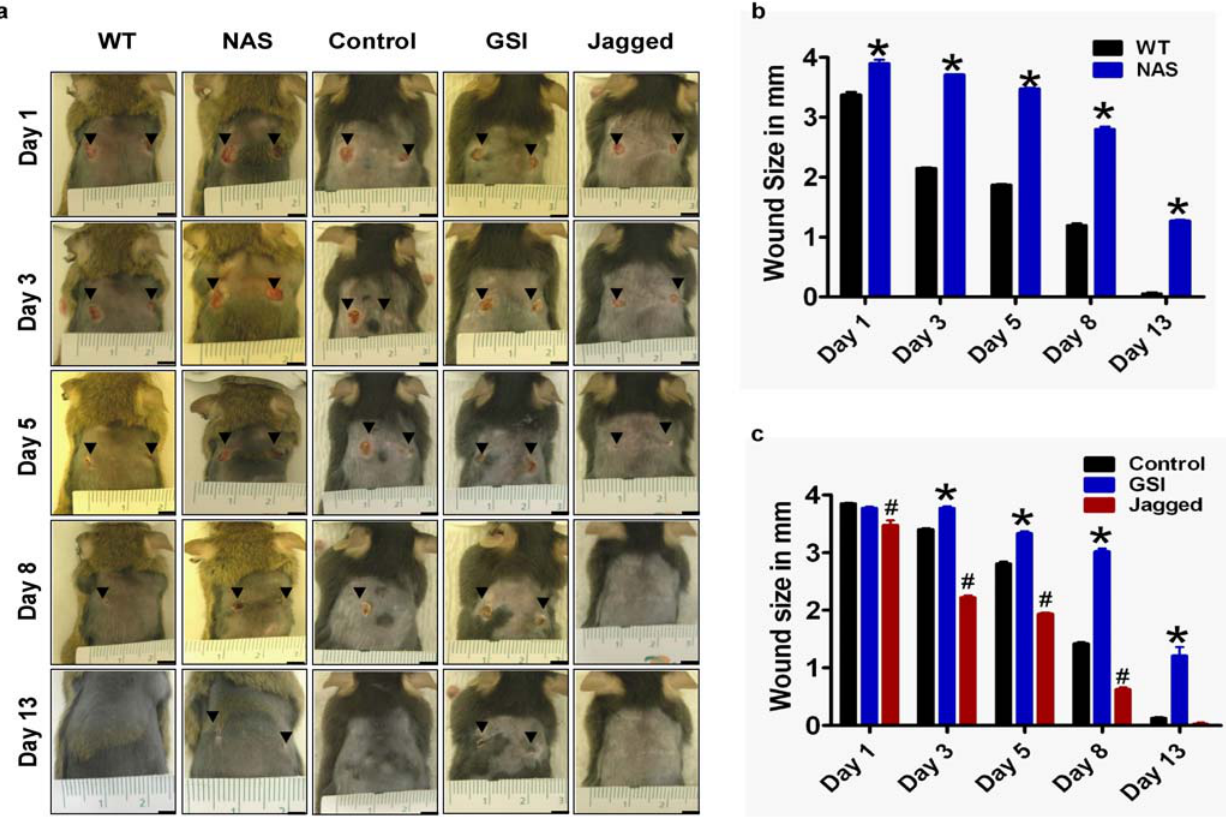
Figure 1. Genetic and pharmacological inhibition of Notch impairs wound healing. Two full-thickness dermal wounds were induced in NAS mice and nontransgenic mice, vehicle-treated control mice, g-secretase inhibitor (GSI)-treated (100 m M DAPT) mice and 15 m M mouse Jagged peptide- treated mice. a. Images of a representative mouse from each group taken on post-injury days 1, 3, 5, 8 and 13 are shown. b. Wound sizes at the indicated time points in NAS and wild-type control mice (WT). c. Wound sizes at the indicated time points in control, GSI-treated and Jagged peptide- treated mice. Values are the mean and SEM (n=6 mice per group). *p , 0.001, # p , 0.01 compared to the control value. Scale bar=4 mm.